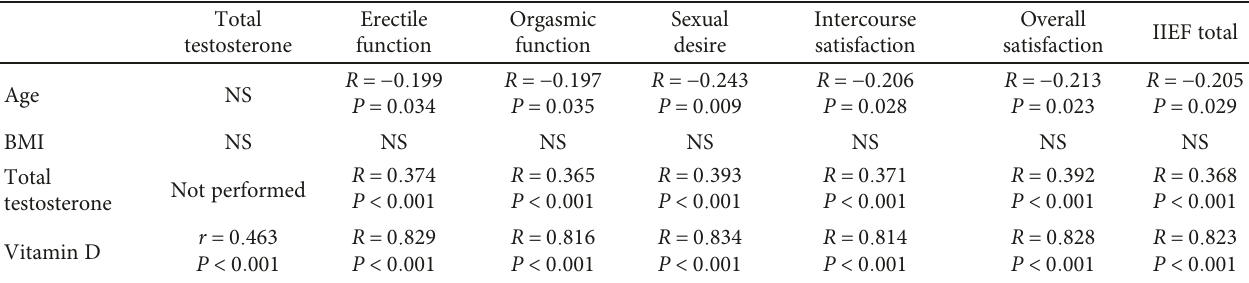
Table 2: Bivariate correlation of general and hormonal parameters with testosterone and sexual parameters at baseline in the total sample.